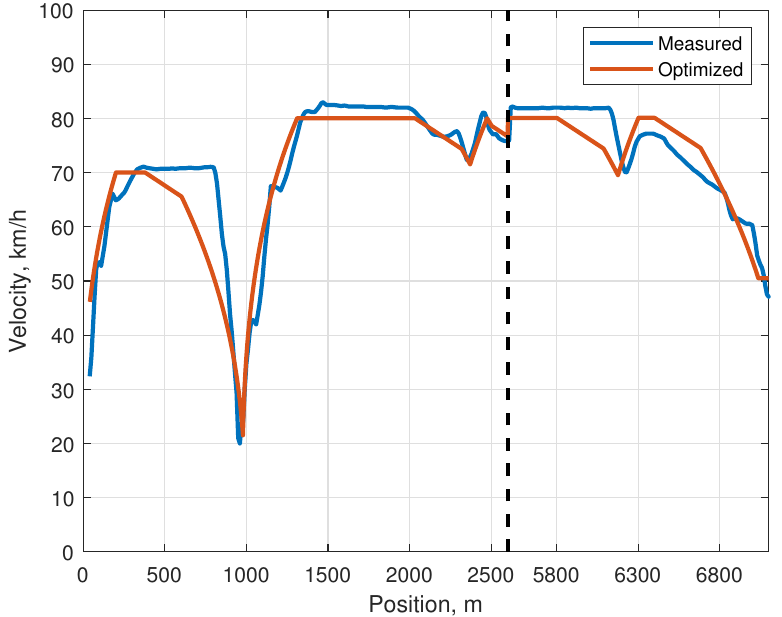
Figure 5. Velocity profile of human test drive (blue line) and MATLAB simulator (orange line). Two selected segments are